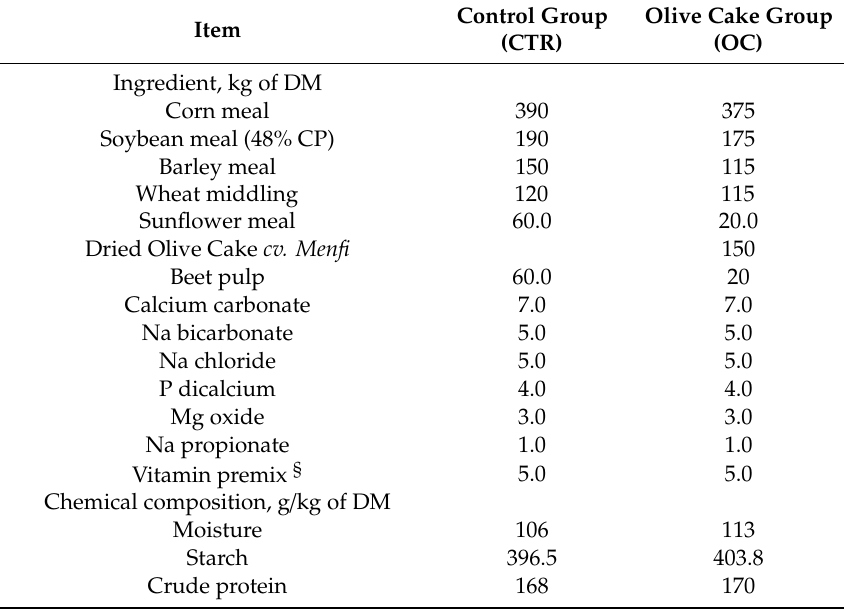
Table 1. Ingredients and nutritional characteristics of the